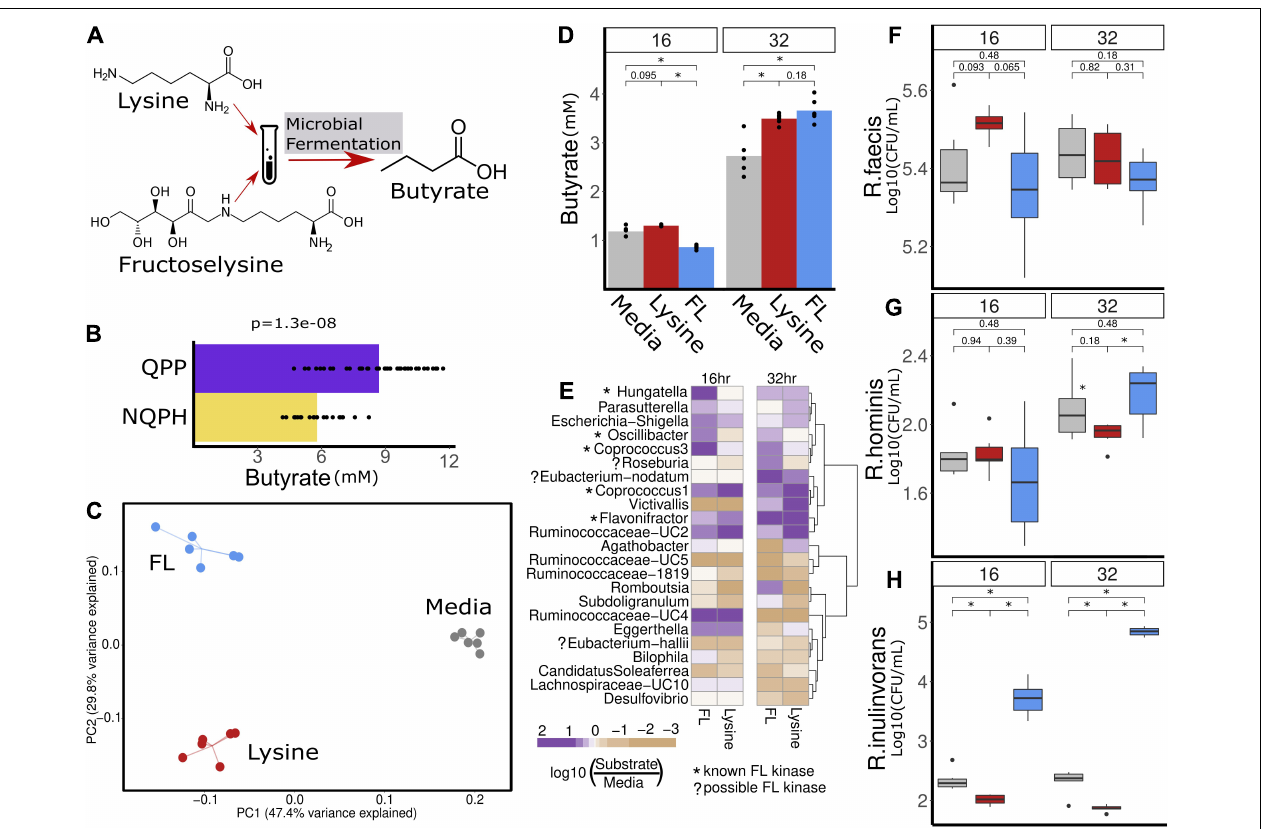
FIGURE 5 | (B) Hypothesized mechanism of action for the stimulation of butyrate production in the microbiome of S1 in response to QPP is the conversion of lysine and/or FL to butyrate. (C) Community structure measured as β -diversity (Jaccard index) indicates differences in microbial composition when treated with lysine or FL. The significant increase in butyrate production in the microbiome of S1 in response to QPP compared to NQPH (A) was recapitulated in treatment with lysine and FL in 32-h fermentation (D) . Multiple organisms were identified by 16S sequencing to be enriched by lysine and/or FL, many of which contain known genes implicated in the conversion of FL to butyrate (E) . Species level investigation of Roseburia by qPCR identified no response of (F) R. faecis or (G) R. hominis to FL or lysine, while the content of (H) R. inulinivorans was significantly increased at both 16 and 32 h in response to treatment with FL. *denotes statistical significance of P -value calculated by the Wilcoxon rank-sum test where alpha <